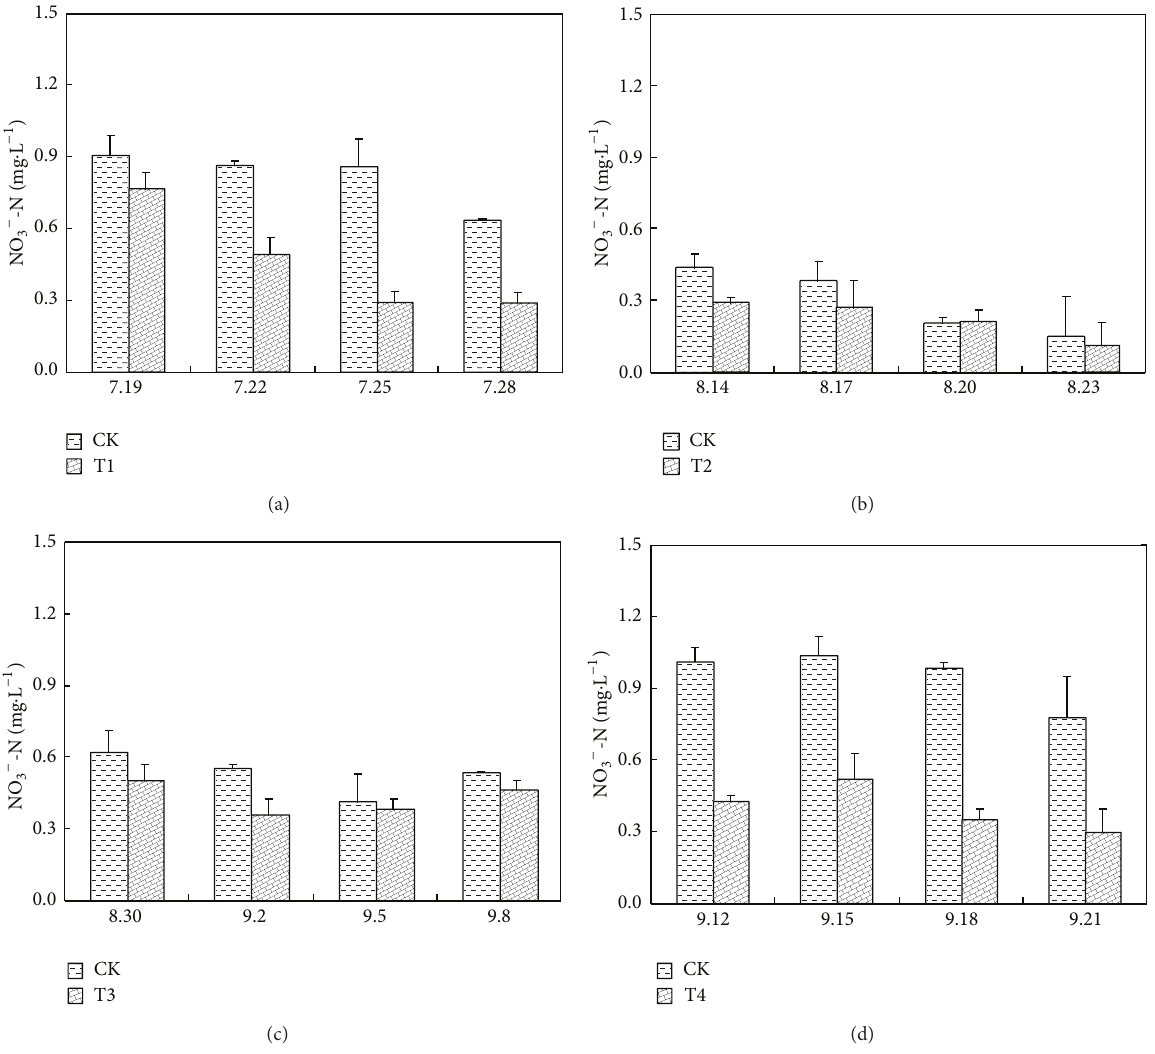
Figure 4: The change of the concentration of NO 3− -N during submergence in 2010. CK indicates alternate drying and wet irrigation; T1, T2, T3, and T4 denote the submergence at tillering stage, jointing-booting stage, panicle initiation stage, and milky stage, respectively. Vertical bars represent ± standard error (SE) of the mean.